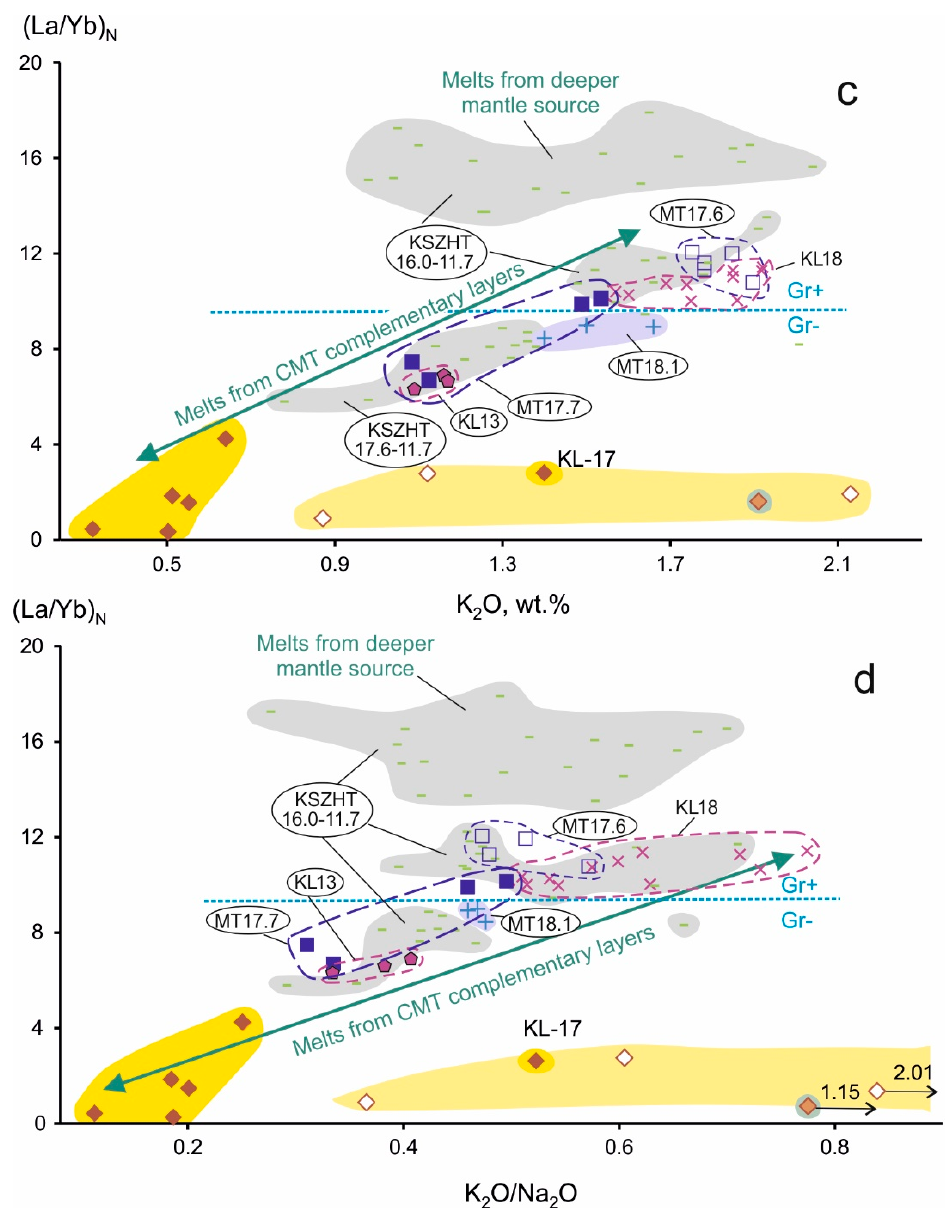
Figure 10. Comparison of the MSF basic pseudotachylytes and the KSZHT volcanic rocks on (La/Yb) N –Yb N ( a ), (La/Yb) N –FeO tot ( b ), (La/Yb) N –K 2 O ( c ), and (La/Yb) N –K 2 O/Na 2 O ( d ) diagrams. Measured major oxide values are used. Symbols are as in Figure 9. In the Meteo Volcano, volcanic rocks of the initial eruption phase (MT18.1) belong to a garnet-free source, those of the intermediate phase (MT17.7) to both a garnet-free and a garnet-bearing deep-seated sources, and rocks of the final phase of this volcano (MT17.6) to a garnet-bearing source. In panel a, model curves of equilibrium partial melting and compositions of garnet-bearing Cpx-poor and garnet-free Cpx-rich deep-seated sources were calculated for the KSZHT volcanic rocks by Rasskazov et al. [20] using equations of [83] and mineral–melt distribution coefficients given in [84]. In panel b, prevalent FeO tot interval is shown as in Figure 9b. For normalization of La/Yb and Yb, the pyrolite composition was used after [77].